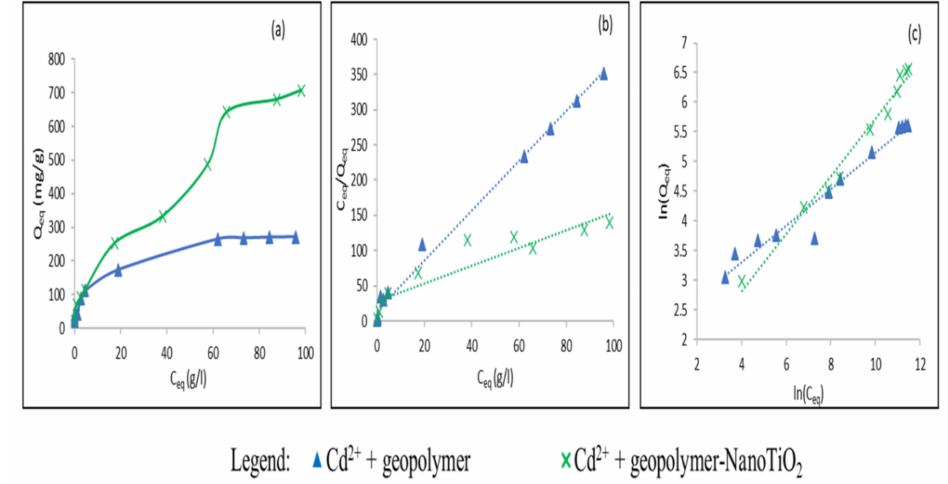
Figure 7. ( a ) Adsorption isotherm of Cd 2+ on geopolymer and geopolymer-NanoTiO 2 composite (volume (15 mL), mass of adsorbent (0.3), pH (6.8), ambient temperature, and stirring speed (250 rpm)), ( b ) Langmuir model, ( c ) Freundlich